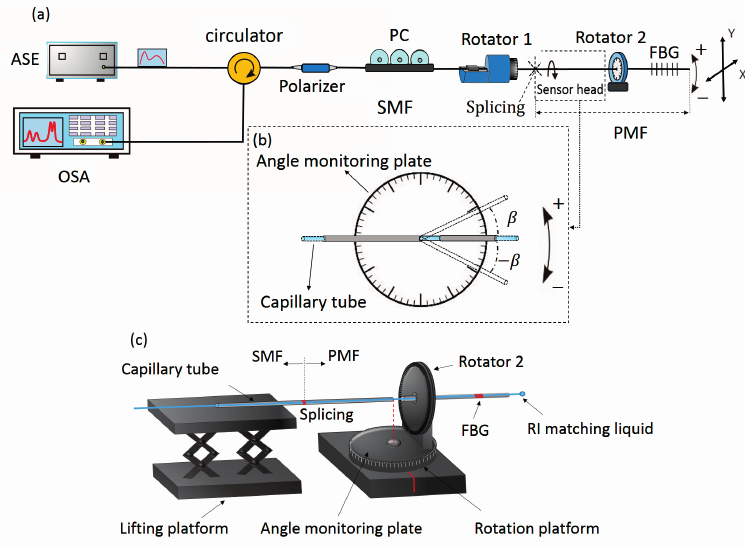
Figure 1. ( a ) Experimental system for bending sensing; ( b ) schematic diagram of the bending angle; ( c ) simulated setup of the inclinometer